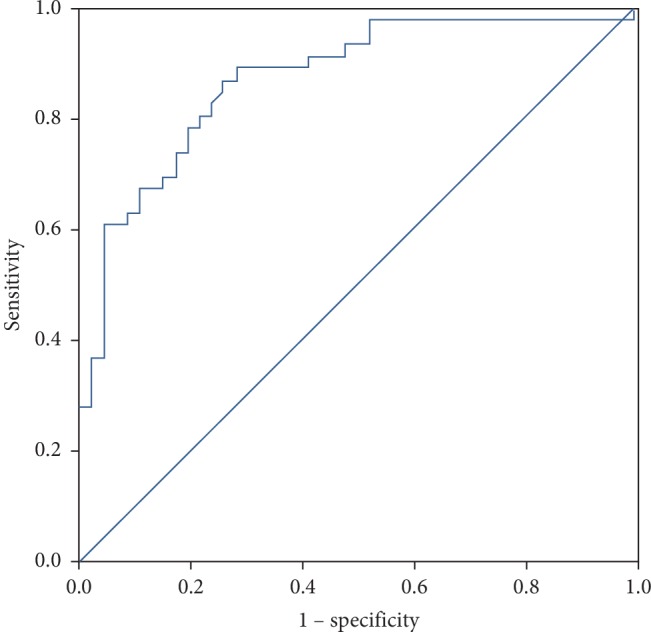
ROC curve analysis for the CYFRA-211, TT, and Hct value in the LCA-AIS group and simple lung cancer group.